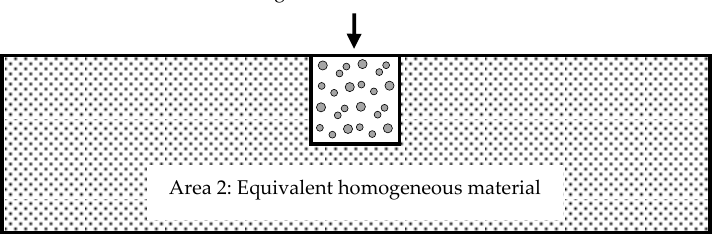
Figure 9. A partition diagram of the specimen with two area.